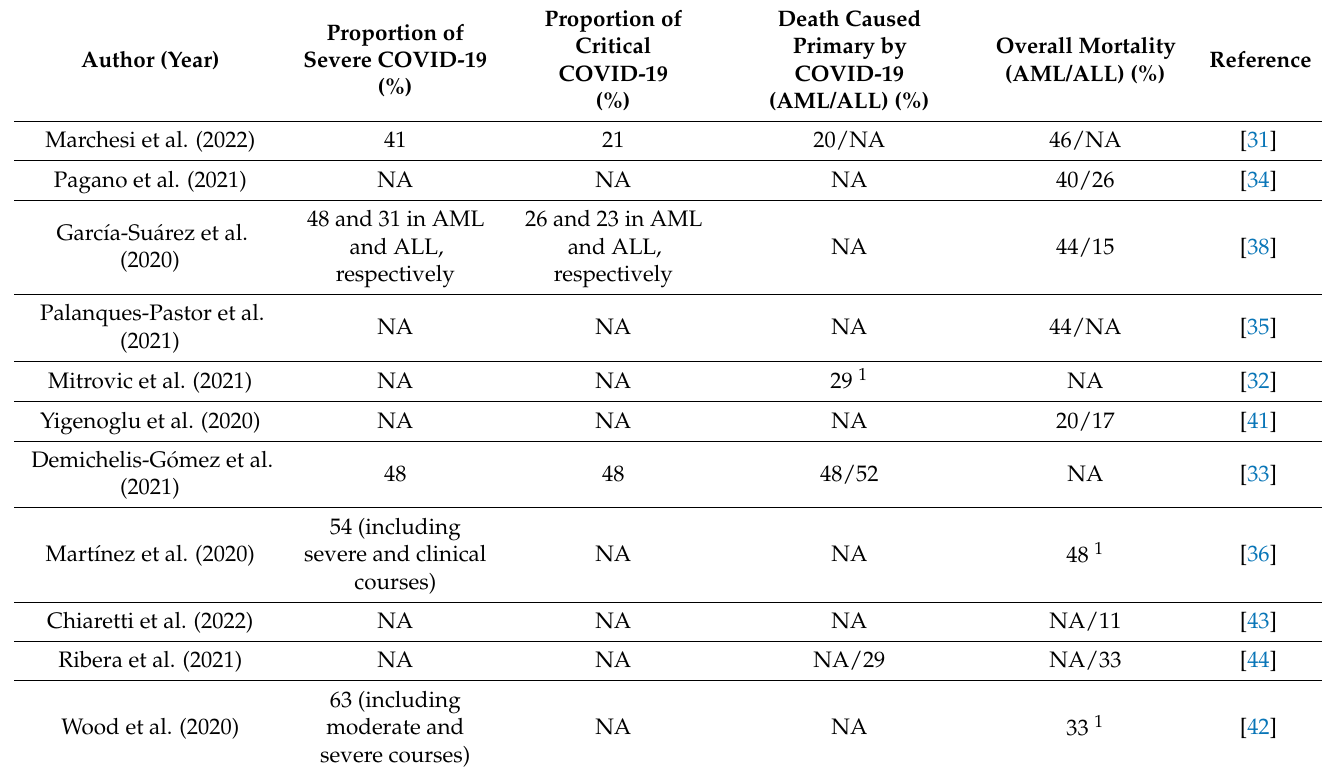
Table 2. Overview of the most important studies on clinical courses of COVID-19 in patients with acute leukemia (Part 2 including COVID-19-related mortality and overall